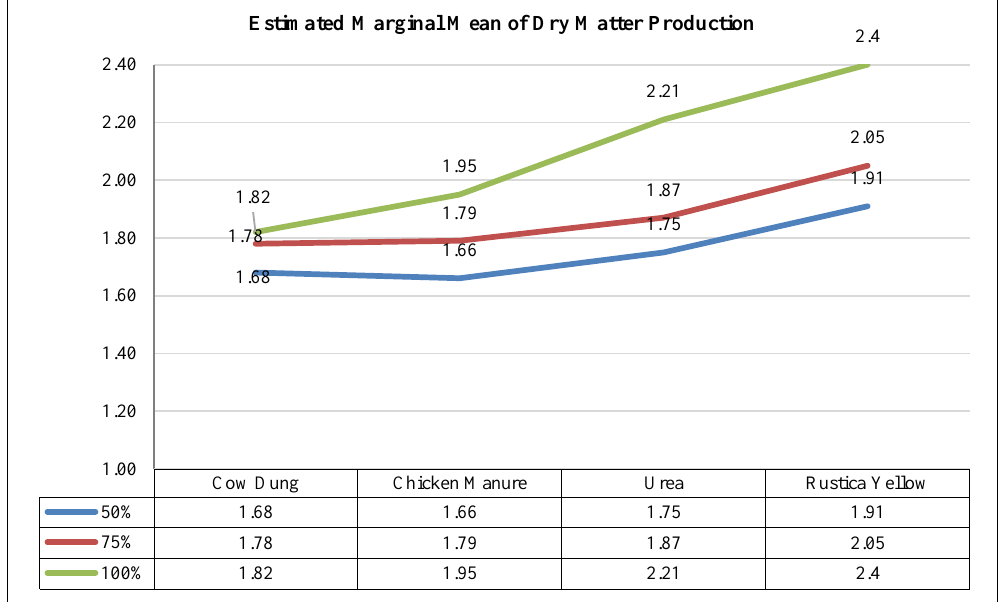
Figure 6. Nitrogen Sources and Levels on Dry Matter